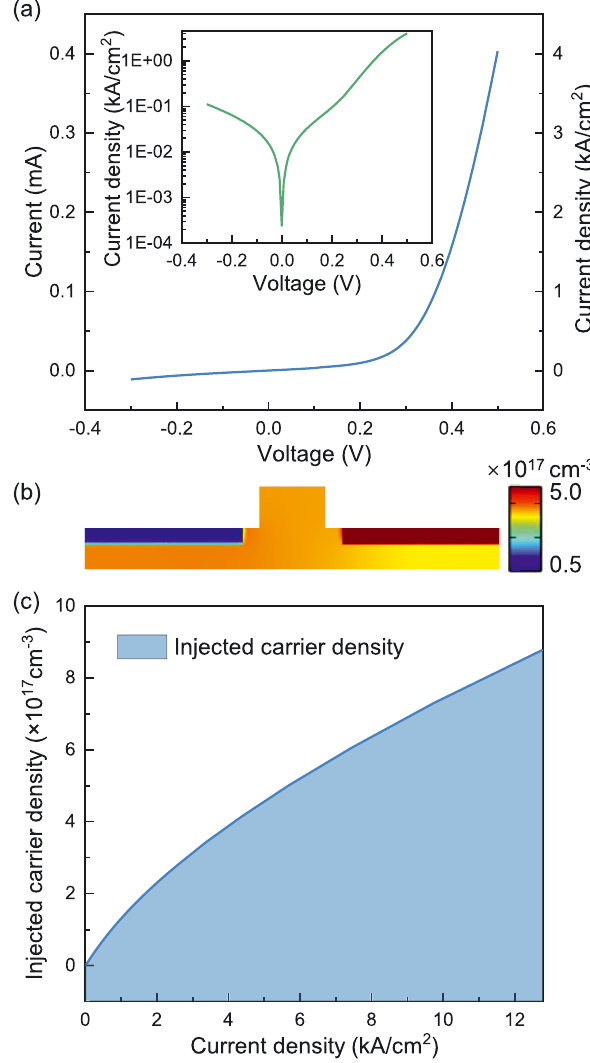
Figure 6: Current – voltage dependency and the calculated injected carrier density for a lateral p – i – n junction with a length of 10 μ m. (a) Dependency of the injected current and the related current density on the voltage. The inset is the semi log current density – voltage relation. (b) Distribution of the injected carrier density with injected current density of 4 kA/cm 2 . (c) The calculated injected carrier density as a function of the current